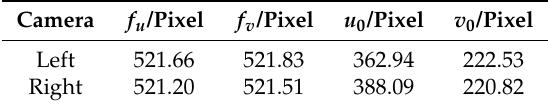
Figure 8. The absolute error of the mean of the estimated 3D coordinates using our proposed method and ITPC method w.r.t ground truth, respectively. ( a ) absolute error in X axis; ( b ) absolute error in Y axis; and, ( c ) absolute error in Z axis. Table 4. The intrinsic parameters of the left and right cameras of the designed robotic bionic